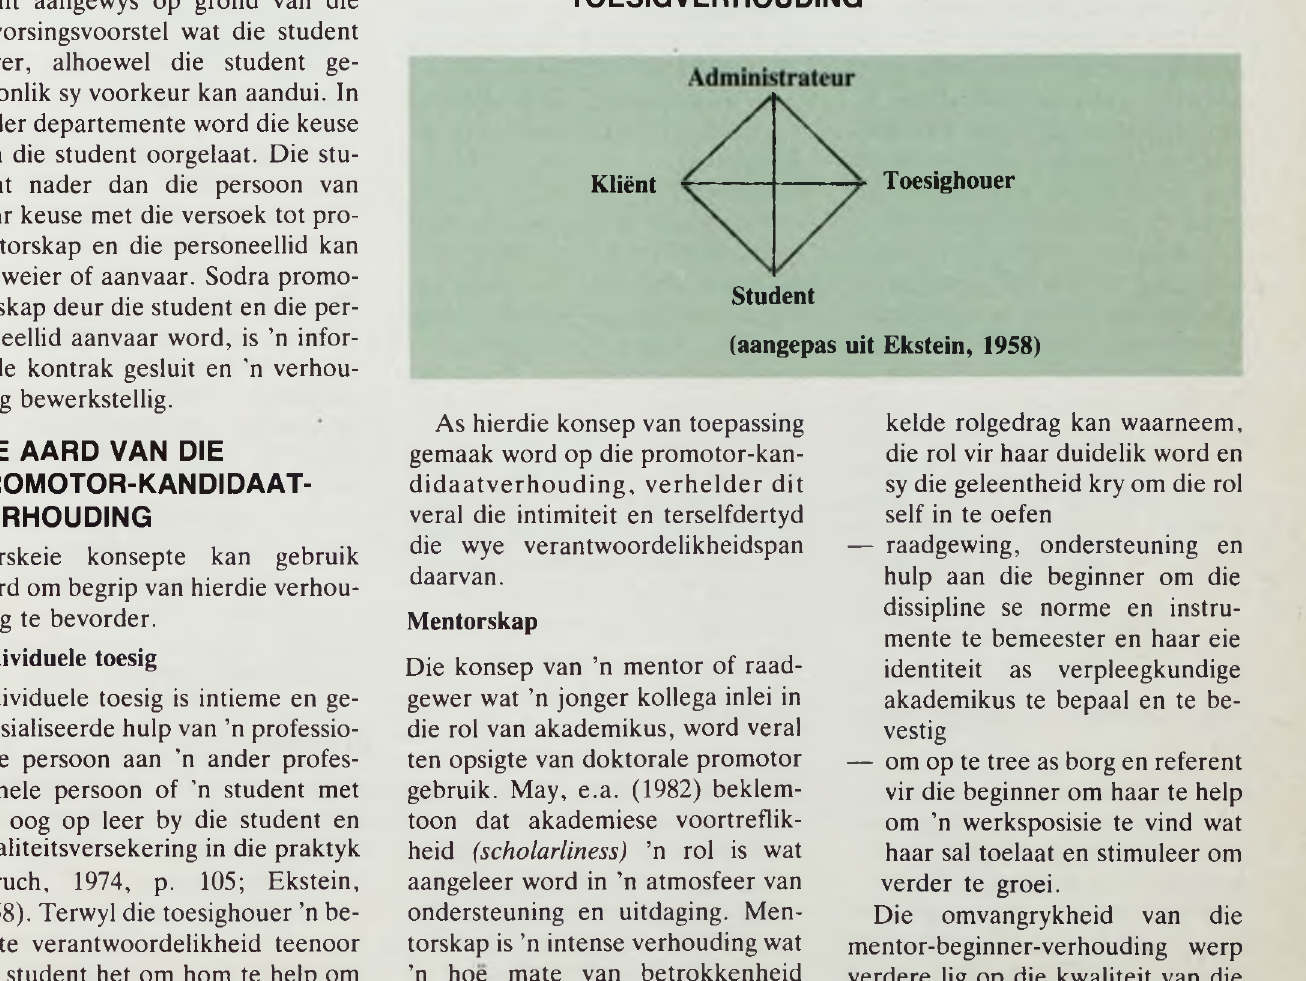
FIGUUR 1: ILLU STR A SIE VAN DIE